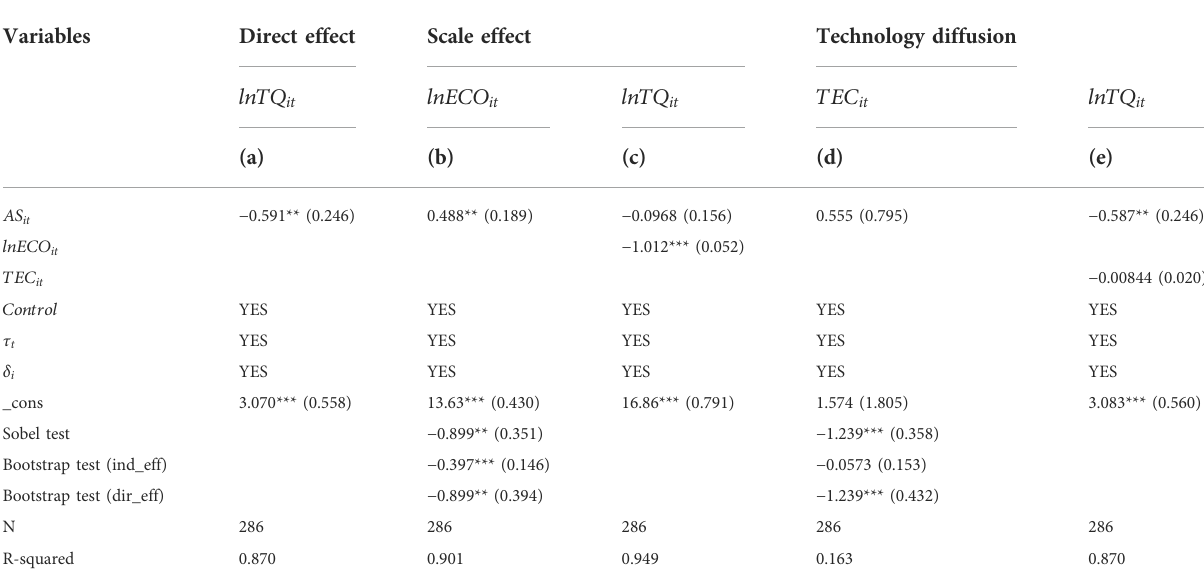
TABLE 8 Mechanism analysis.